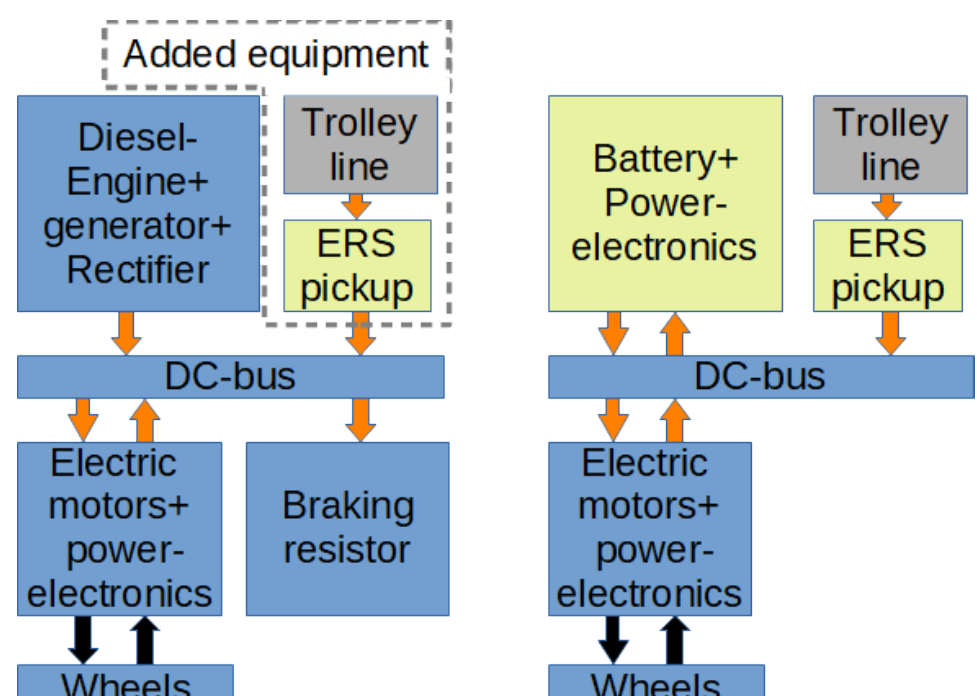
Figure 4. The main drive train components and power flows between them. To the left, the presently tested diesel-electric trucks using the ERS. The conventional diesel-electric trucks are similar but lack the ERS pickup and the trolley line. To the right is the battery-electric truck simulated in this work. The energy consumption at the DC-bus of the real vehicle is compared with calcula- tions based on the simulation model. One of the main uncertainties is the average rolling resistance of the tires. When the rolling resistance was set to 1.4%, the average calculated DC-bus energy consumption was 358 kWh/cycle while the measured DC-bus energy con- sumption was 361 kWh; this is a difference of only 1%, which is considered good enough. The measured and calculated DC-bus energy consumption during the recorded cycles can be seen in Figure 7. A rolling resistance of 1.4% seems reasonable since 2% is a rough value often used in the industry, and it seems reasonable that it would include some margin.